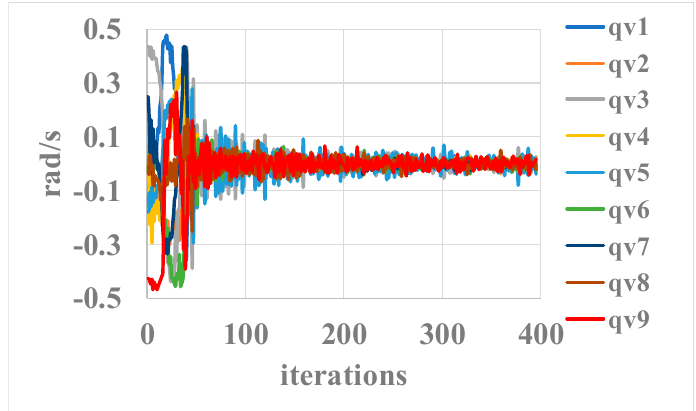
Figure 14. Detailed result of the improved PHUVS with the KF-SVSF method in the static positioning experiment. ( a ) Image error norm. ( b ) Norm of error vector.